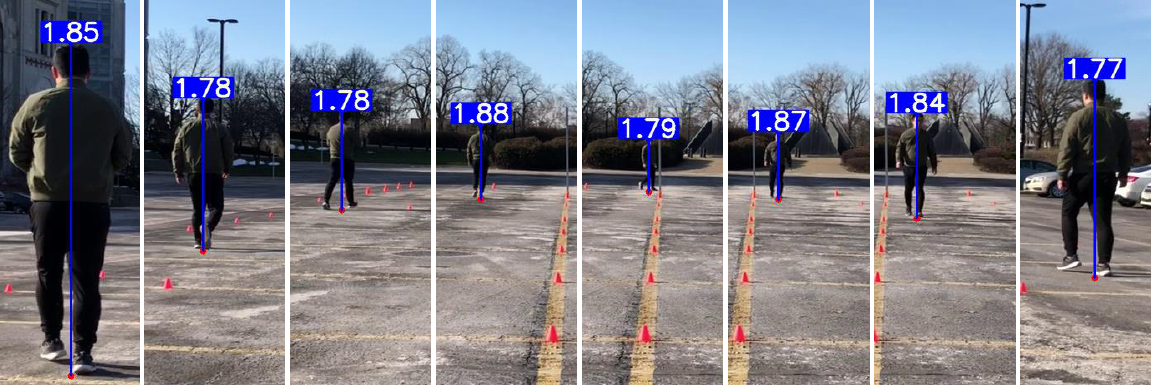
Figure 9. Person’s estimated height over frame. Texts above the person are heights in